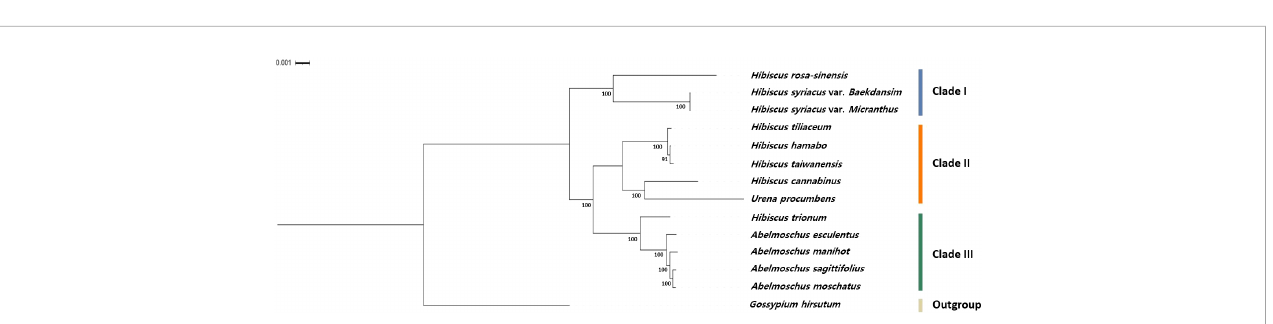
FIGURE 5 Phylogenetic relationships based on the whole chloroplast genomes of 13 species of the tribe Hibisceae. The bootstrap values were based on 1000 replicates and are denoted next to the branches.